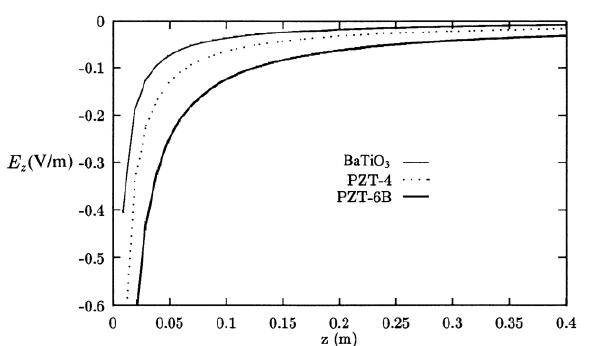
Figure 3. Vertical stress in different magneto-piezoelastic solids due to a concentrated vertical line load of intensity 1.0